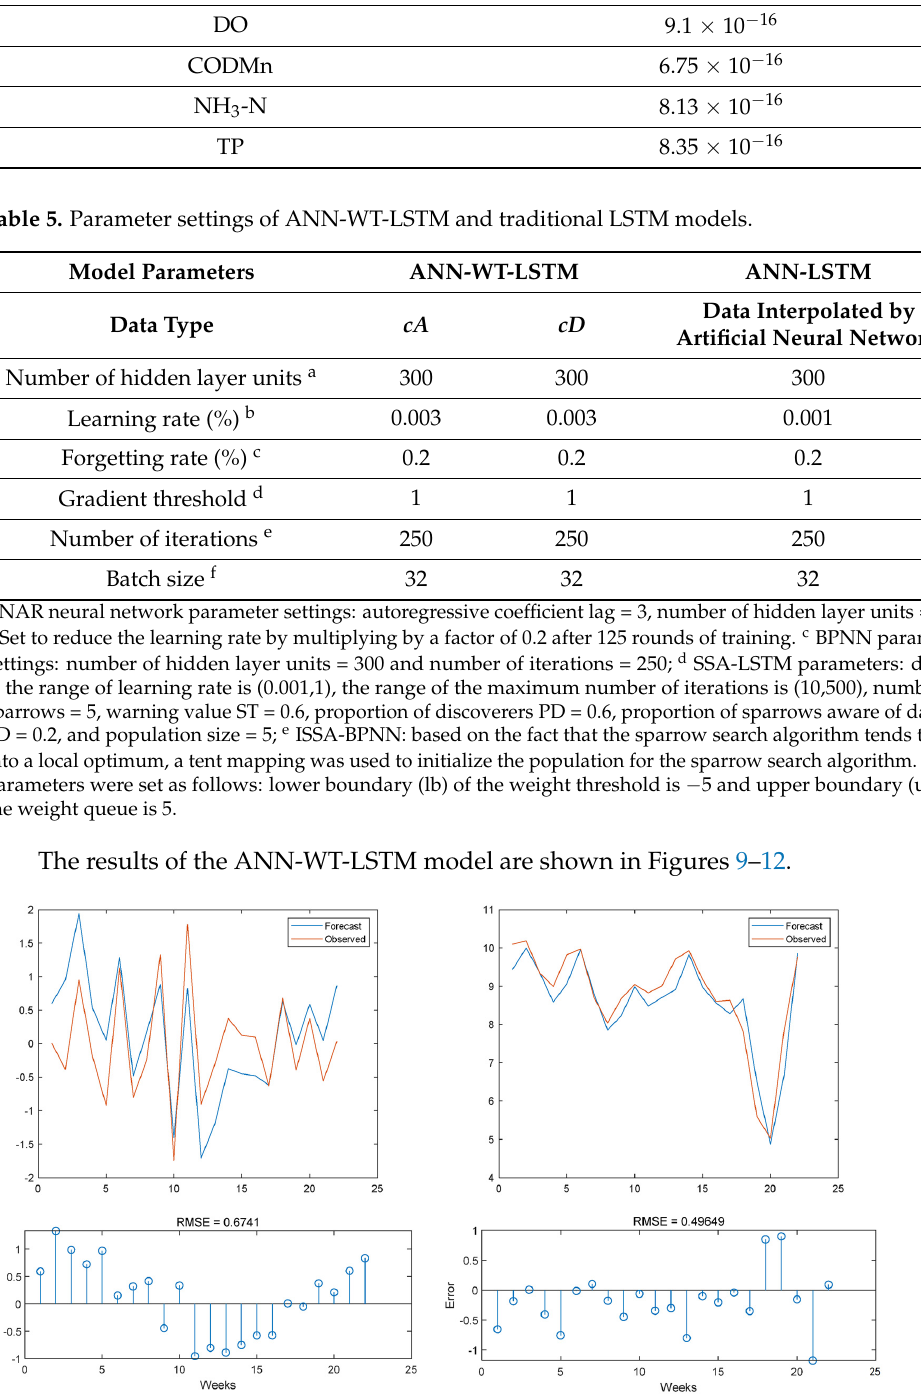
Figure 10. Prediction results and error images of the ANN-WT-LSTM model for high-frequency and low-frequency parts of the CODMN verification set. Figure 11. Prediction results and error images of the ANN-WT-LSTM model for high-frequency and low-frequency parts of the TP verification set.